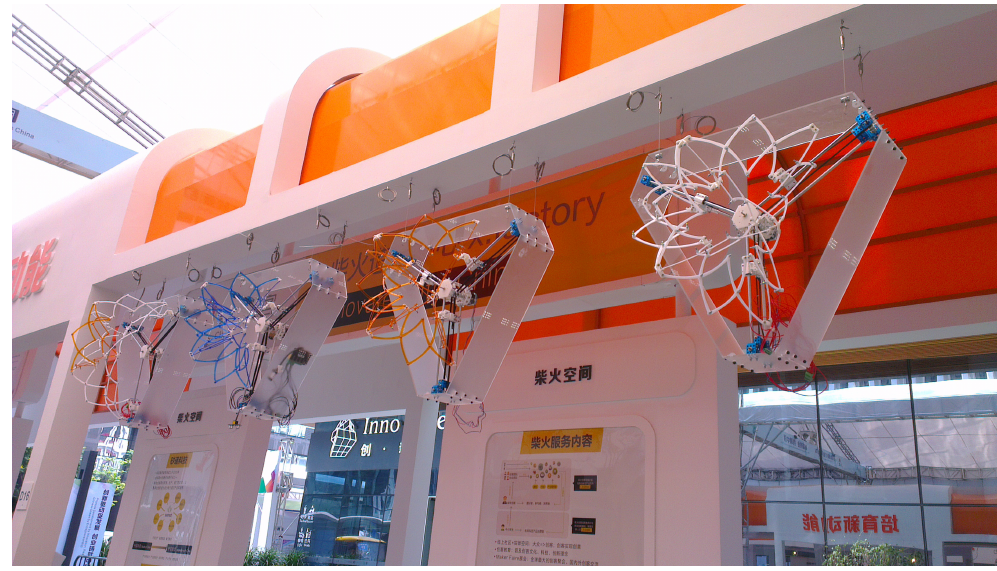
Figure 10. RCCE component prototype